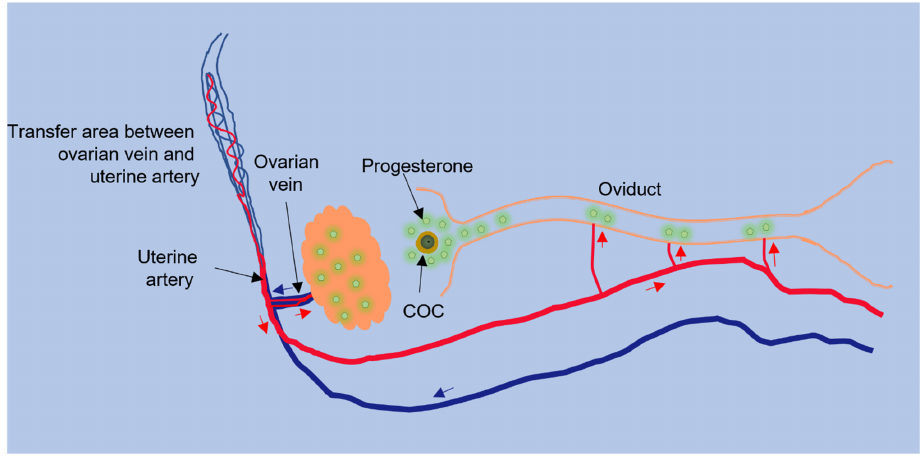
Figure 1. Counter-current transfer of progesterone. The oviductal sperm reservoir may be acted upon by progesterone from the ovary via counter-current circulation. Progesterone produced by the ovary can move into the ovarian vein and then the uterine artery that supplies blood to the oviduct, resulting in progesterone produced in the ovary undergoing less diffusion before reaching the oviduct (modified from [59]). The arrows indicate blood flow in the arterial (red) or venous (blue) system. Progesterone may be synthesized by the oviduct epithelium in several species such as horses and rabbits. In the equine oviduct, enzymes of the steroid biosynthesis